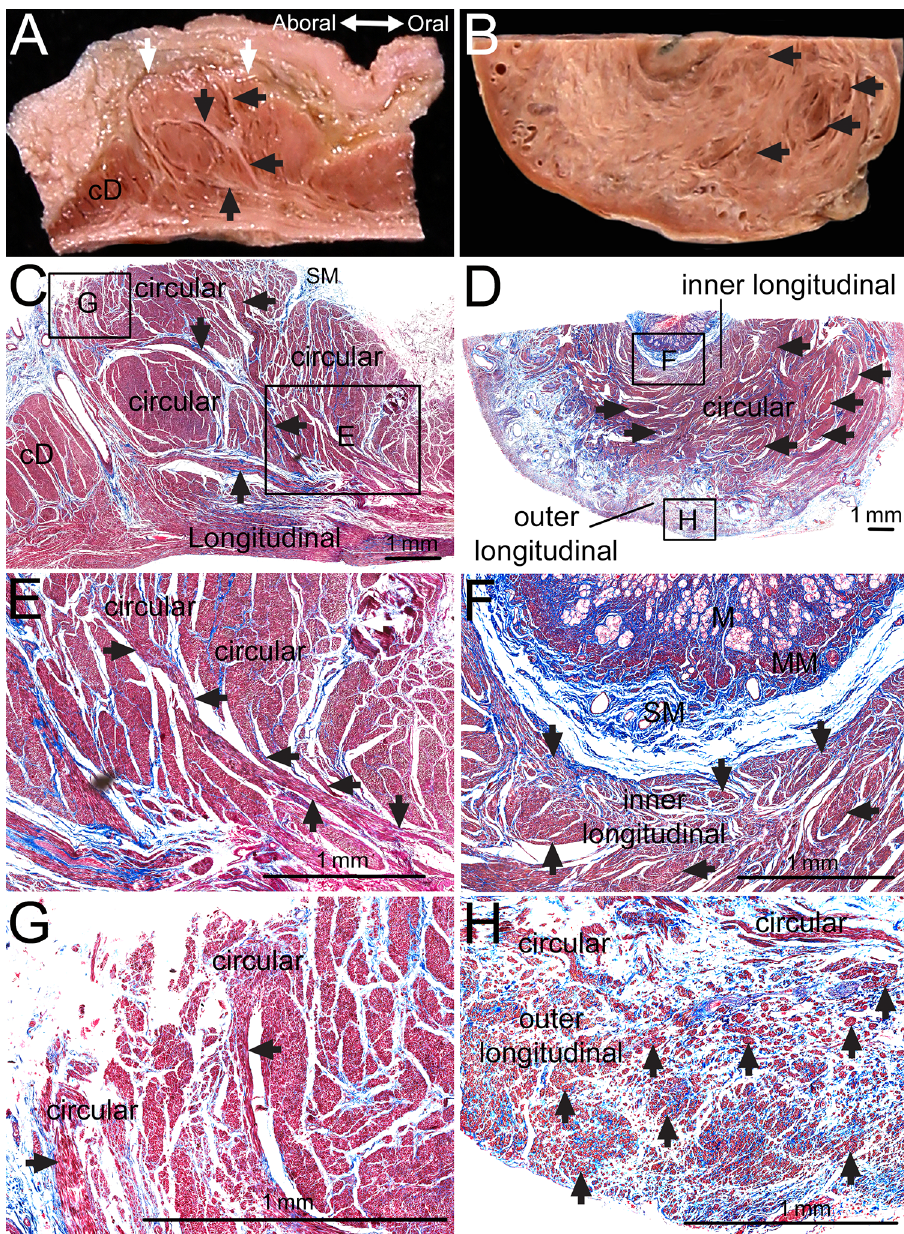
Figure 5. Histological examinations of the pyloric sphincter (PS) with the corresponding macroscopic observations. ( A , C ) In a longitudinal section of the PS (white arrows) on the lesser curvature (LC) side, some longitudinal bundles (black arrows) entered the PS and divided it into several parts, as seen in macroscopic observations ( A ) and the corresponding histological examinations ( C ). ( C ) The internal parts of the PS were divided more than the external parts by the muscle fascia and connective tissue connecting to the submucosae (SM). ( E , G ) Are enlarged views of the rectangular insets in ( C ). ( E ) Some longitudinal bundles (black arrows) that entered the PS were divided into several bundles that intermingled with and connected to the sphincteric circular bundles. ( G ) Some longitudinal bundles (black arrows) at the aboral end of the PS that entered the PS were connected to the circular bundles of the PS. ( B , D ) There were three muscle layers in an axial section including the lesser and greater curvatures of the aboral end of the PS (inner longitudinal; arrows, thick circular, and outer longitudinal muscle layers) seen in macroscopic observations ( B ) and the corresponding histological examinations ( D ). ( F , H ) Are enlarged views of the rectangular insets in ( D ). Some inner longitudinal bundles were found between the thick circular bundles of the PS. ( F ) The inner longitudinal bundles (arrows) were arranged adjacent to the SM in the aboral end of the PS. ( H ) Outer longitudinal bundles (arrows) were located external to the circular bundles in the PS wall. M mucosae, MM muscularis